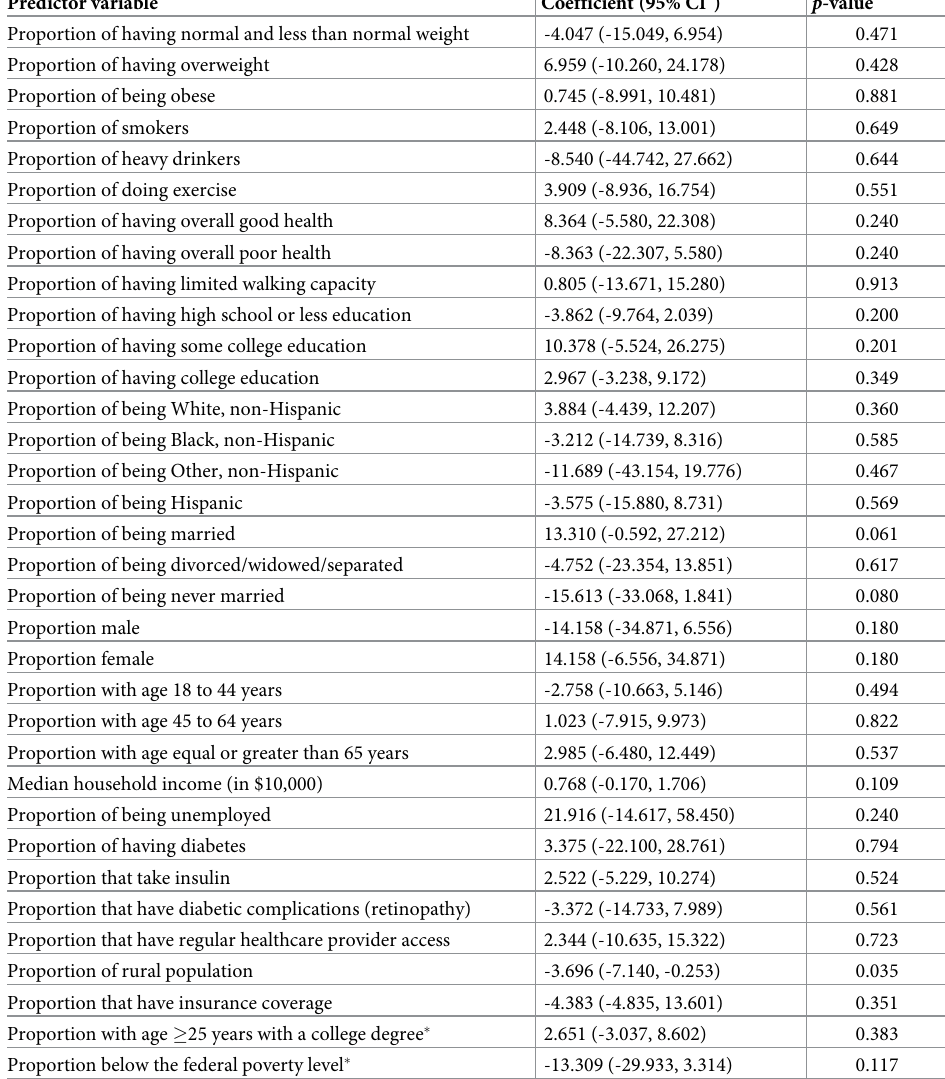
Table 7. Univariable associations between county characteristics and clusters of Diabetes Self-management Edu- cation (DSME) program participation rates in Florida,